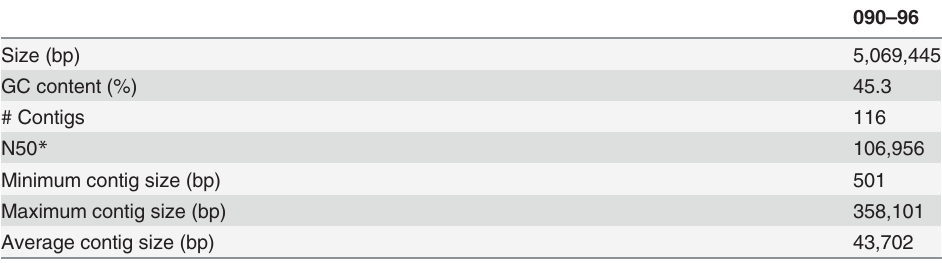
Table 1. Summary report of the de novo assembly of 090 – 96.